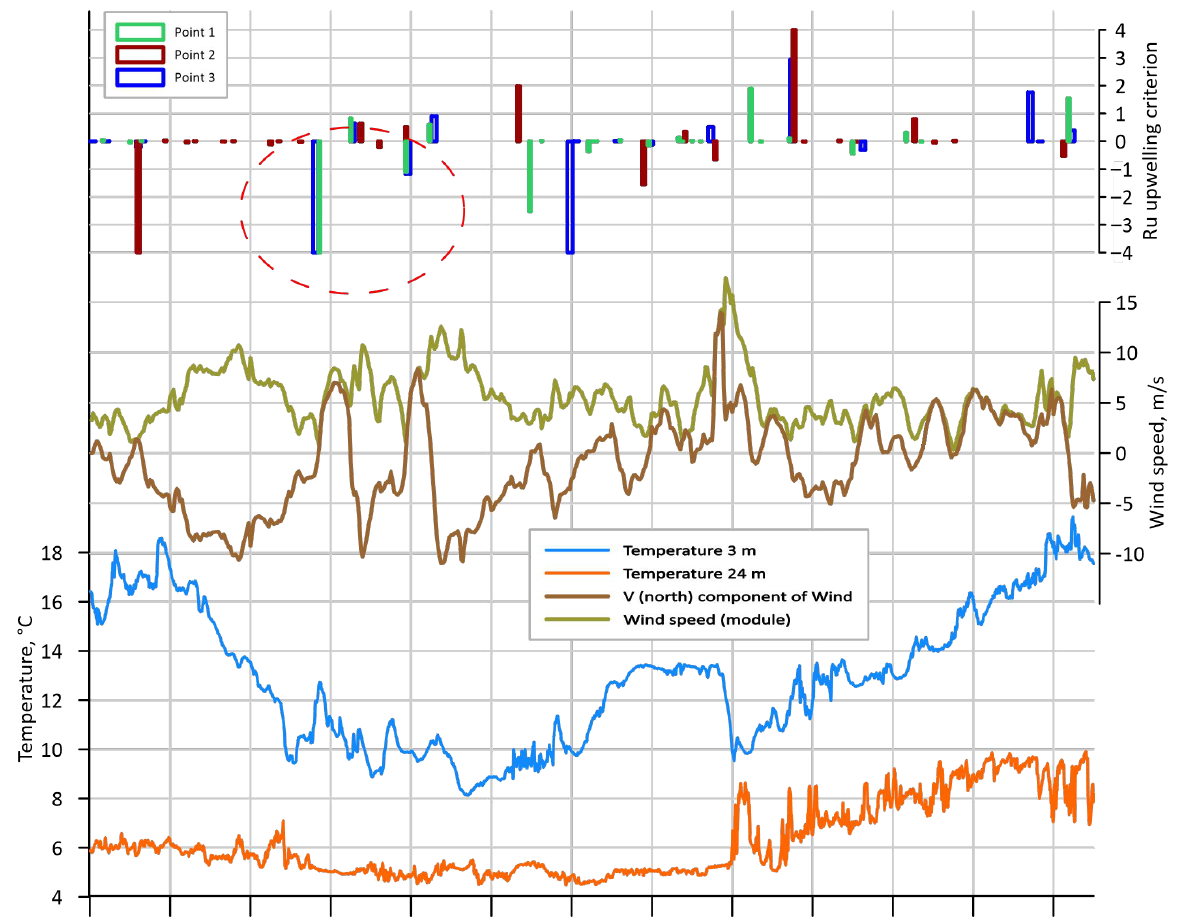
Figure 4. Water temperature and upwelling criterion at points 1, 2, and 3 from 1.04.2016 to 1.11.2016. Blue triangles mark upwelling events.